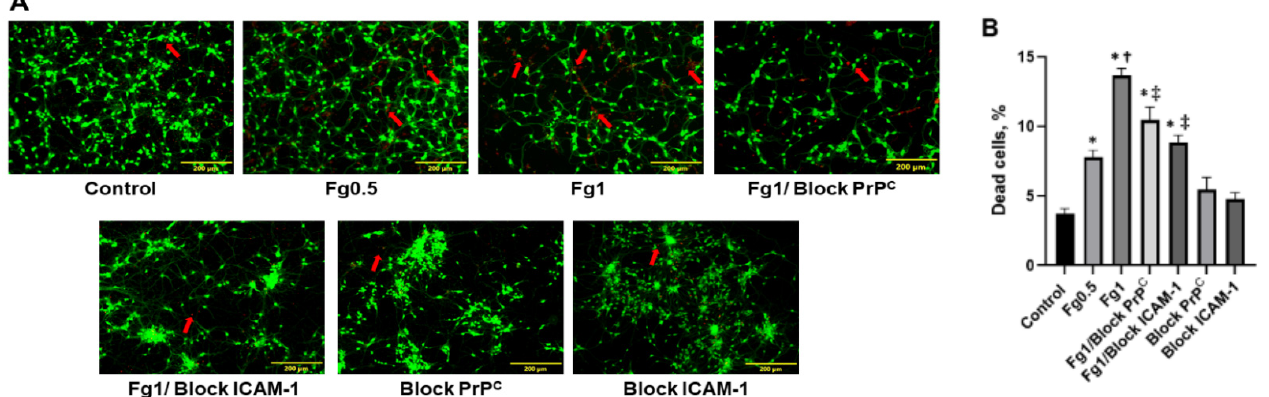
Figure 1. Neuronal cell death induced by fibrinogen (Fg). ( A ) Representative images show staining of live/dead neurons that were treated with medium alone (control), 0.5 mg/mL of Fg (Fg0.5), 1 mg/mL of Fg (Fg1), 1 mg/mL of Fg (Fg1) in the presence of a cellular prion protein (PrP C )-blocking peptide (Fg1/block PrP C ), 1 mg/mL of Fg in the presence of a function- blocking antibody against intercellular adhesion molecule-1 (ICAM-1) (Fg1/block ICAM-1), the prion protein-blocking peptide alone, or the ICAM function-blocking antibody alone. Hirudin was present in all experimental groups to prevent the conversion of Fg to fibrin. ( B ) The summary of the image analyses for the detection of live neurons using a live/dead assay. An automatic cell count was performed based on the fluorescence signal threshold of the images provided by the OLYMPUS CellSens Dimension Desktop 2.3. Arrows indicate exemplary dead cells shown in red. Data are presented as the average of number of dead cells as a percent of the total number of cells in a selected constant area of interest in each experimental group. p < 0.05; ∗ —vs. Control, †—vs. Fg0.5, ‡—vs. Fg1; n = 4. 3.2. The Association of Fg with PrP C and ICAM-1 on the Surface of Neurons The specific associations between Fg and its neuronal receptors PrP C and ICAM-1 were detected with PLA in two separate sets of experiments: one to define an interaction of Fg with PrP C (Figure 2, A, B, Ba, F) and another to define an interaction of Fg with ICAM-1 (Figure 2, C, D, Da, G) on the surfaces of neurons. The quantification of the PLA signal density per cell corresponded to the molecular interactions observed between Fg and its receptors under study. Data showed that there were significantly higher interac- tions between Fg and both of its receptors on neurons compared to those in the control group (untreated cells). The interaction between Fg and the IgG, isotype control (non- specific neuronal receptor) was significantly lower than its interactions with its receptors (Figure 2E). Furthermore, representative 3D reconstructions of the PLA signals from z- stack images demonstrated that the PLA signals were formed all along the neurons (Fig- ure 2, Ba, Da). In addition, we incorporated technical controls within the PLA by individ- ually omitting each of the primary antibodies to detect any possible non-specific binding (Figure S2). The lack of PLA signals in any of the three negative controls (Figure S2) sug- gested a high specificity of the used antibodies and validated the PLA in the present study. As an additional control test, neurons in PLA were counterstained with the microtubule- associated protein 2 (MAP2) to specifically identify them (Figure 2H,I). Images clearly show that the PLA signal was from MAP-2-positive cells, i.e., neurons.